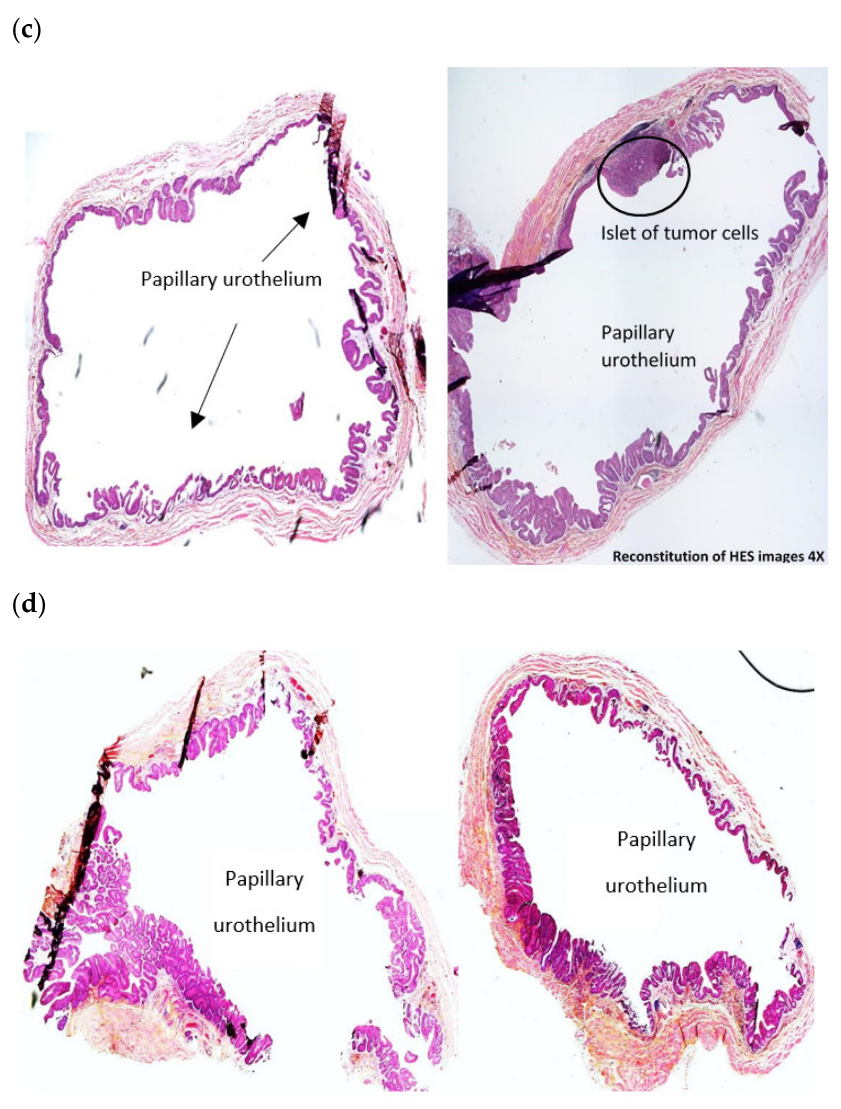
Figure 2. Tumor response grades (adapted with modification from [30]) and bladder tumor typical images corresponding to different response rates. ( a ) No response (NR): bladders with strong muscle-infiltrative tumor; ( b ) Moderate response (MR): bladders with few tumor cells or islets of tumor cells in several areas; ( c ) Near Complete Response (Near CR); ( d ) Complete Response (CR).